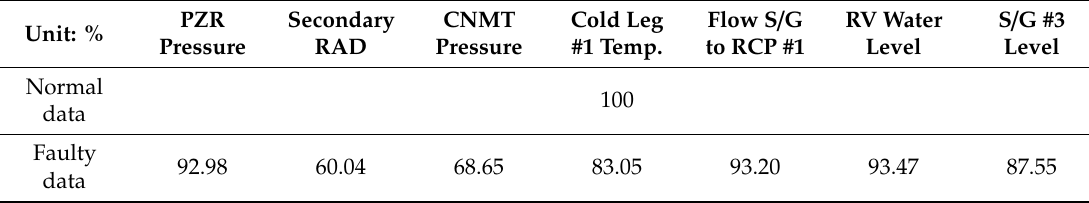
Figure 7. Example trends of ( a ) accident diagnosis success from normal data test, and ( b ) diagnosis failure from error-injected data for the secondary radiation sensor. Table 2. Diagnosis accuracy of GRU with error-injected and no-error sensor data.